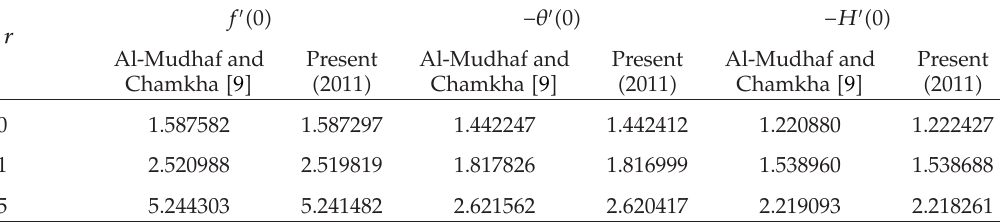
Table 3: Comparison values of f (cid:5) (cid:5) 0 (cid:6) , − θ (cid:5) (cid:5) 0 (cid:6) and − H (cid:5) (cid:5) 0 (cid:6) with di ff erent parameter r .